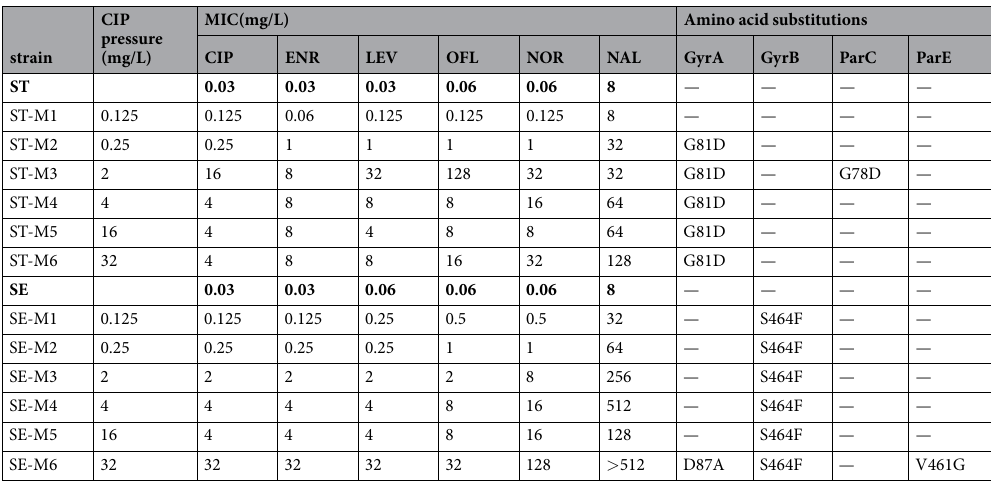
Table 1. Antimicrobial susceptibility and mutations in target genes of parental strains and their respective mutants. ST: Salmonella Typhimurium; SE: Salmonella Enteritidis. M1, M2, M3, M4: serial selected mutants; - : no mutation. CIP: ciprofloxacin; ENR: enofloxacin; LEV: levofloxacin; OFL: ofloxacin; NOR: norfloxacin; NAL: nalidixic acid; TET: